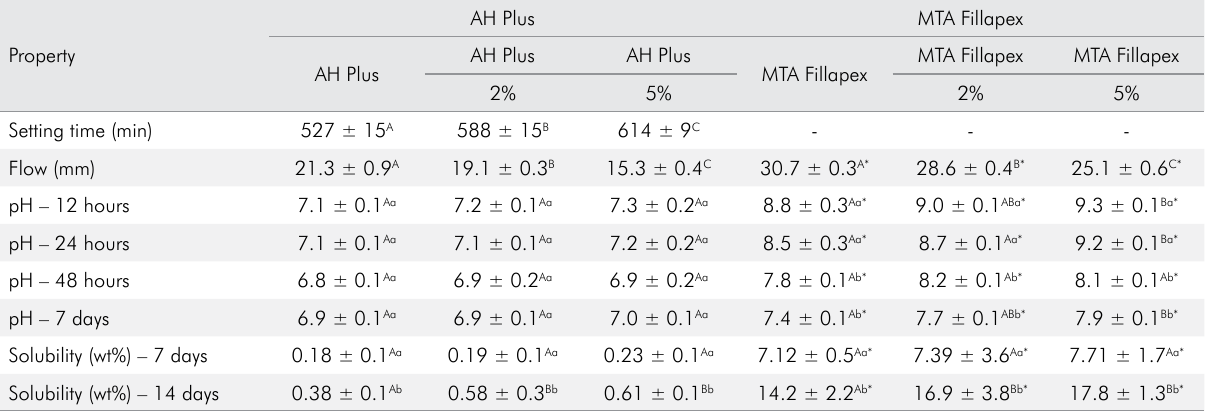
Table. Results for the physicochemical properties (mean ± standard deviation) of the sealers evaluated: wt%, percentage weight